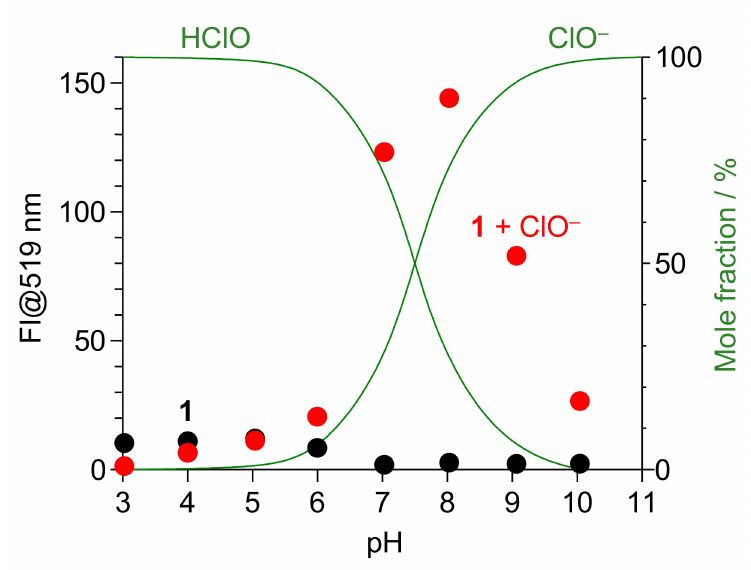
Figure 6. Fluorescence intensity of 1 at 519 nm in water / MeCN mixtures (8 / 2 v / v ) with di ff erent pH, (red) with and (black) without ClO − (50 equiv). The mole fraction of HClO and ClO − calculated based on Equation 1 are also